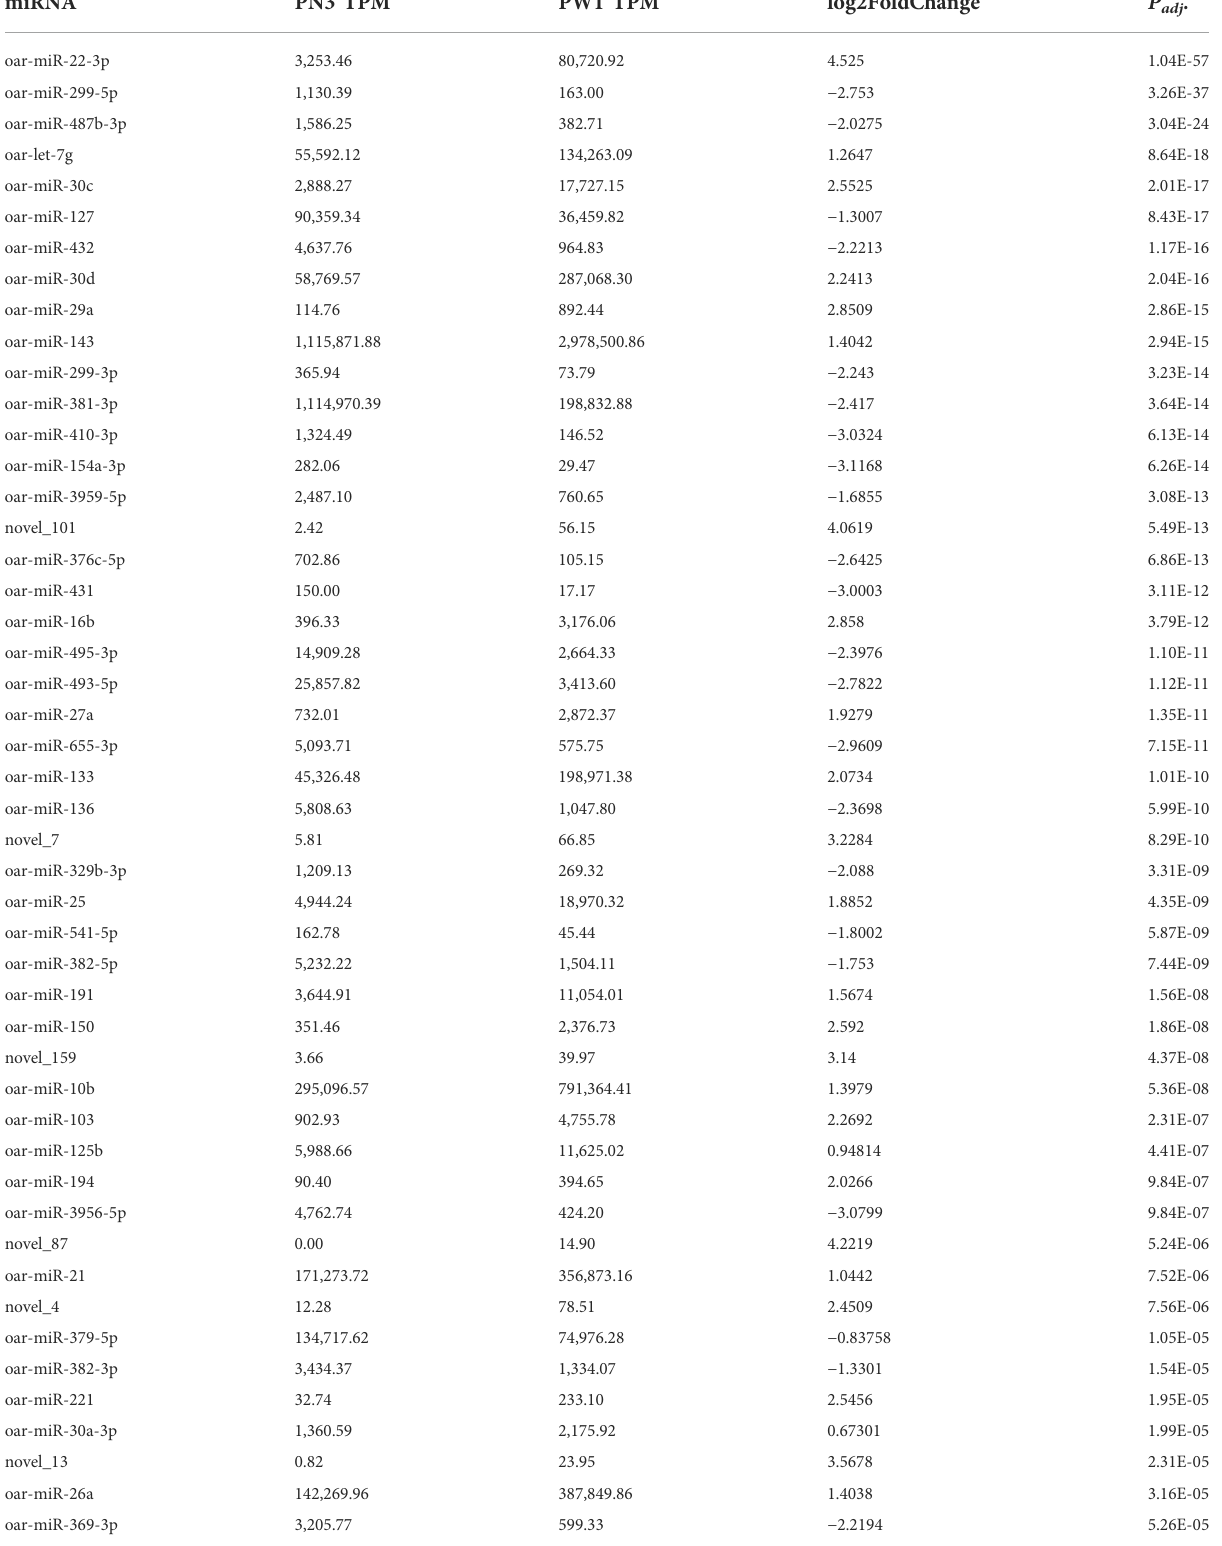
TABLE 4 Differentially expressed miRNA during prenatal to postnatal transition phase (PN3 = gd133; PW1 = pd42) by signi fi cance level. miRNA PN3 TPM PW1 TPM log2FoldChange P adj